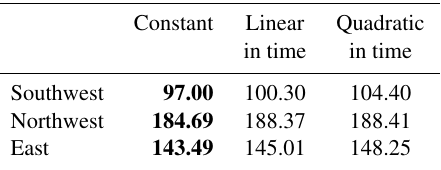
Table 5. BIC values for nonstationary models in the scale parame- ters of GPD models fitted to the tree-ring-reconstructed PDSI from 1700 for each